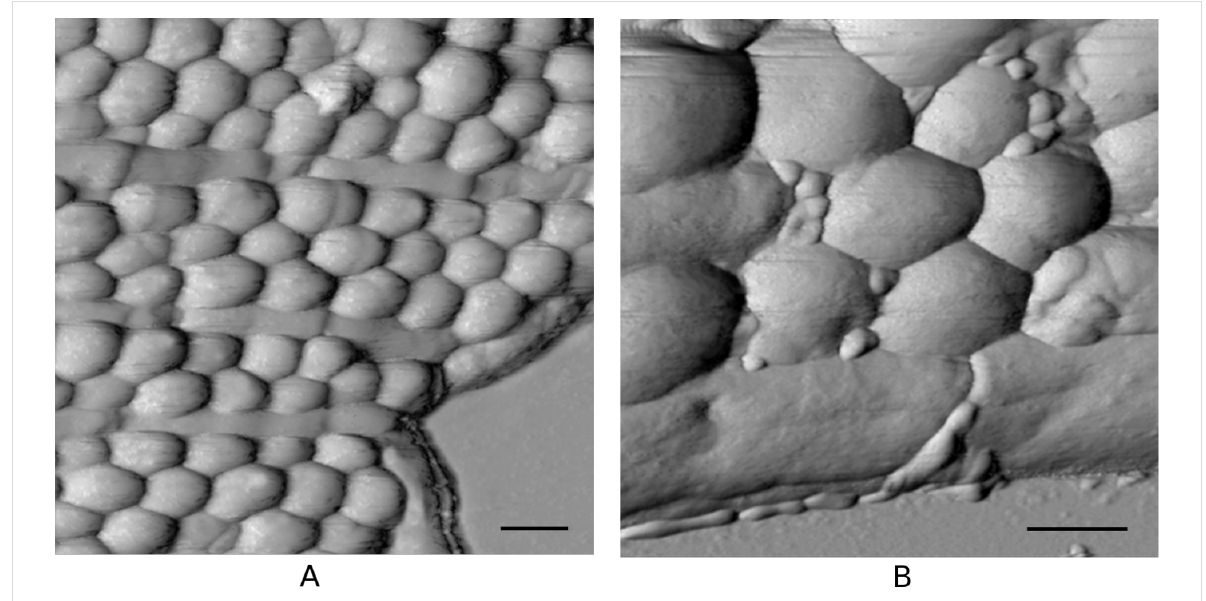
Figure 3: Topographic AFM images of S. aureus and B. licheniformis mixture before (a) and after (b) interaction with IgG–Au conjugates. Scale bar is 500 nm for both panels.